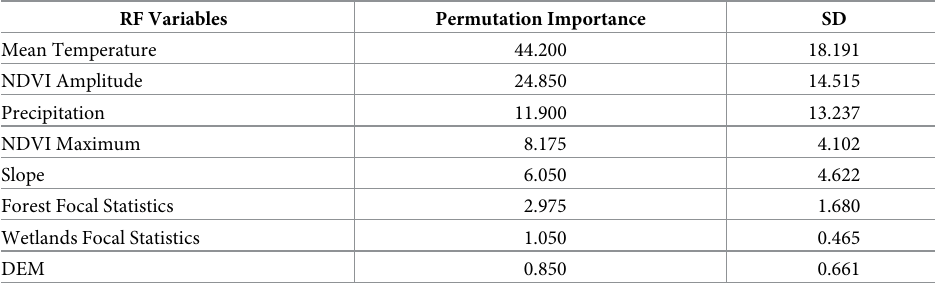
Table 2. Random forest variable permutation importance.